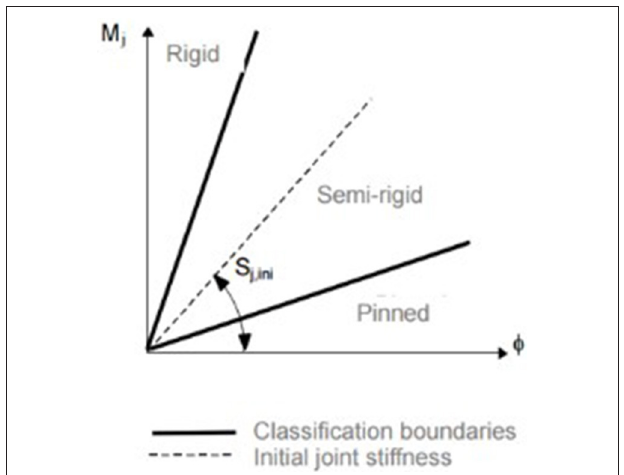
FIGURE 2 | Connection classification by initial rotational stiffness, figure from Eurocode ( EN 1993-1-8, 2005).